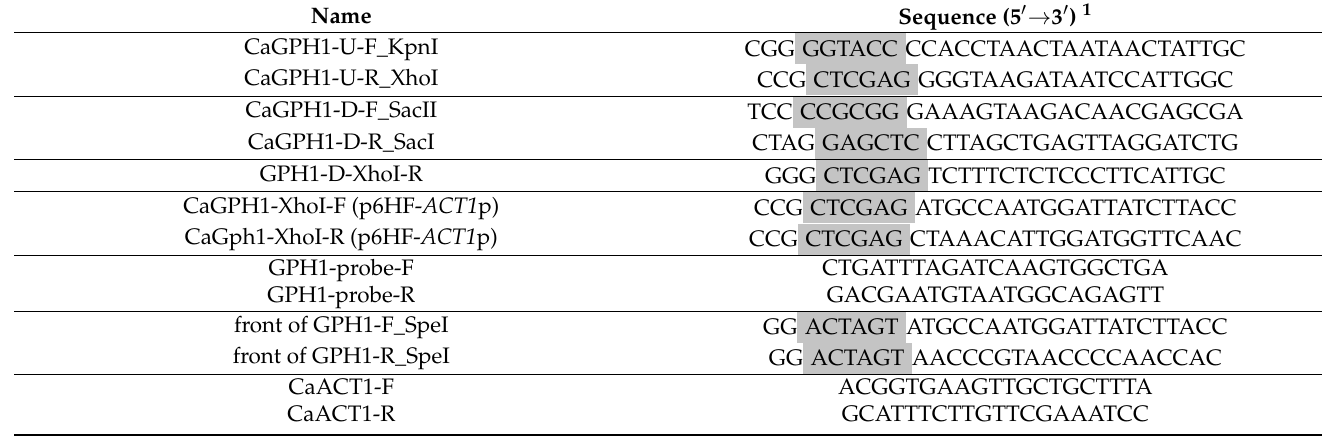
Table 2. Synthetic oligonucleotide primers used in this